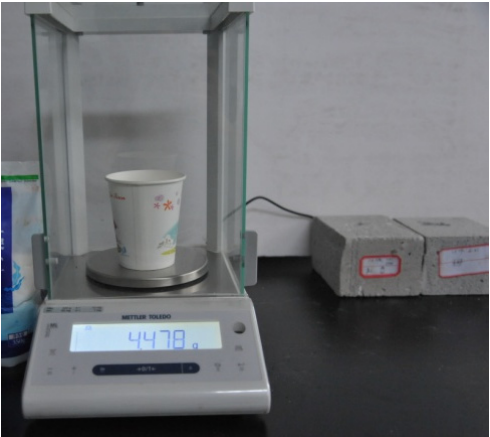
Figure 4. The electronic balance.